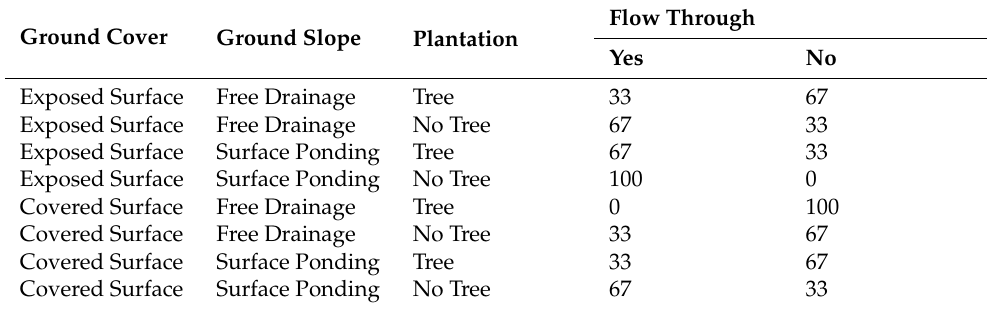
Table 2. Example of determination of conditional probabilities based on knowledge elicitation. Ground